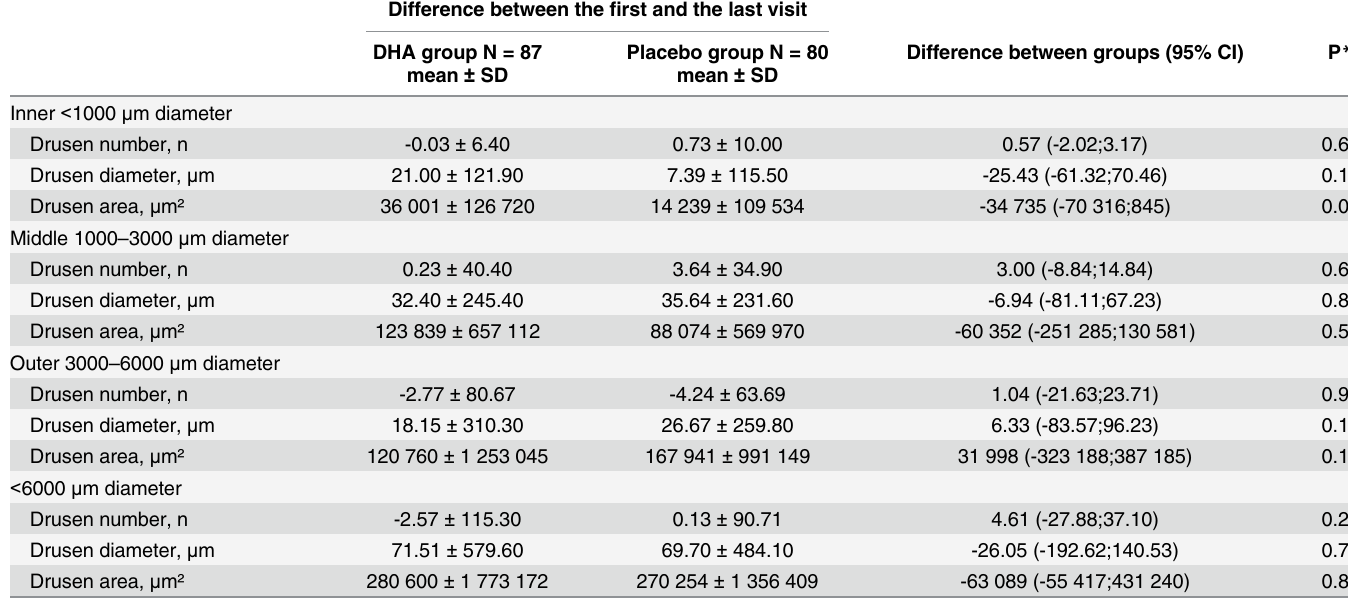
Table 3. Associations of DHA supplementation with drusen remodeling.